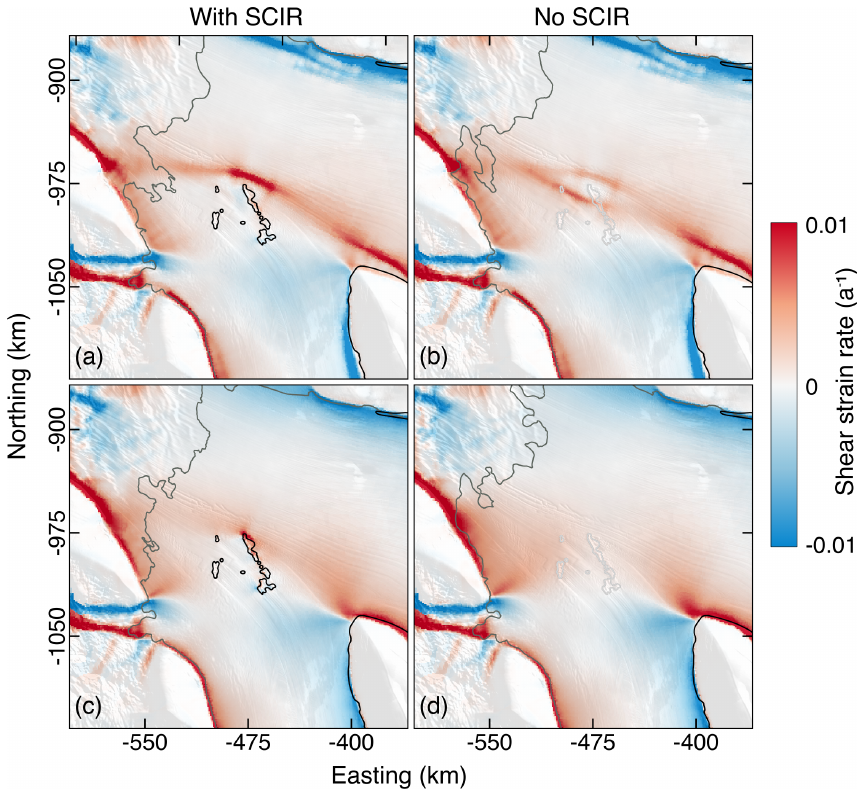
Figure 12. Model shear strain rates near the SCIR for (a, b) spatially variable ice properties ( B inv model) versus (c, d) uniform ice properties ( B u model). Grounding-line positions are from the appropriate B inv or B u reference and perturbed